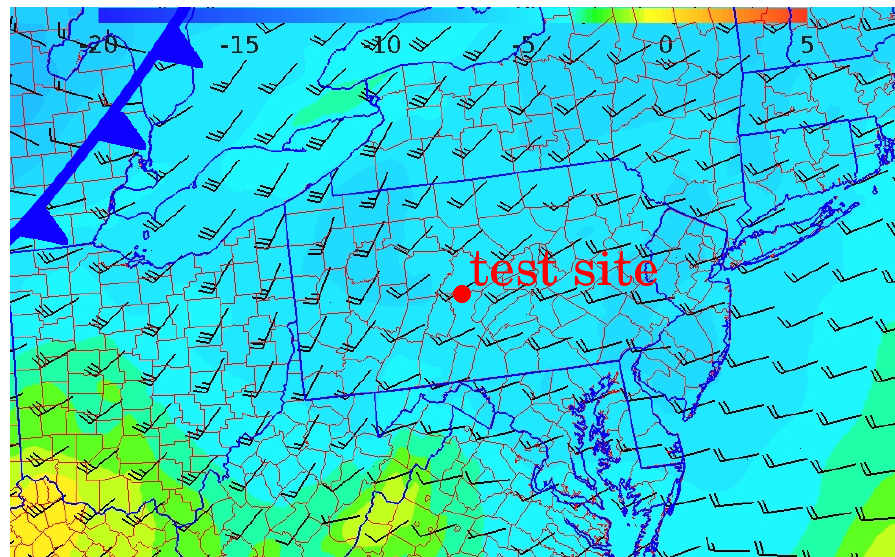
Figure 10. Wind and temperature at 925 mbar (approximately 750 m MSL) at 12:00 EST on December 6, 2018, approximately the midpoint of the test. The test site is located at the red dot, the approaching front can be seen as an abrupt wind shift along the eastern border of Michigan.